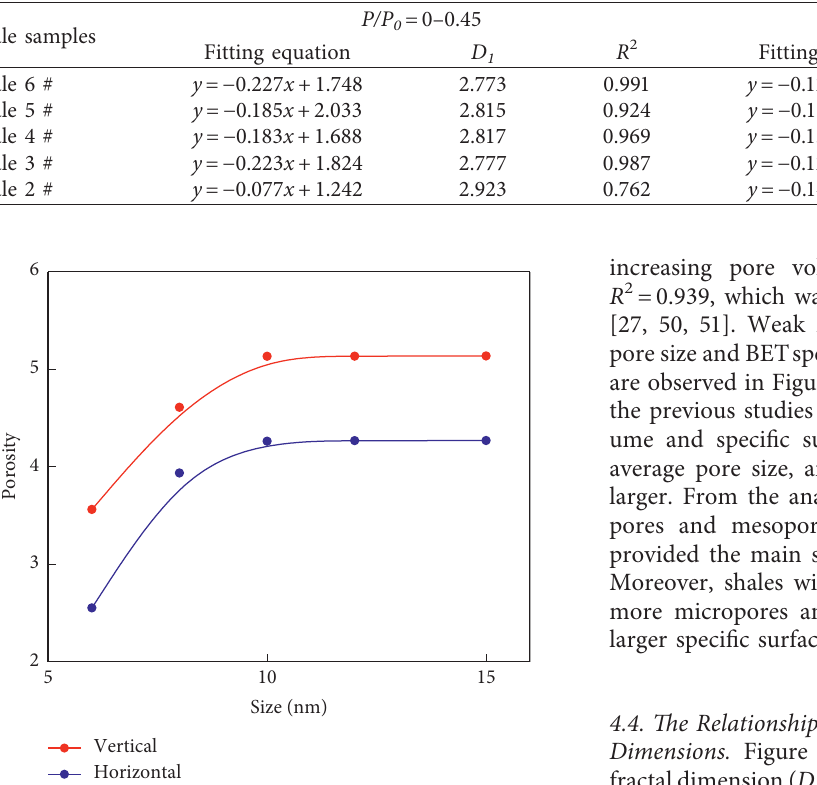
Table 4: Fractal dimensions derived from the FHH model.